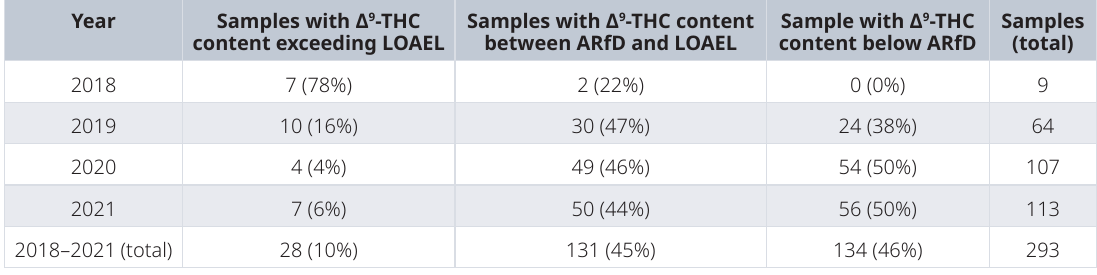
Table 2. Results 1 of THC analysis in commercial hemp-based products from the German market (2018–2021). Year Samples with Δ 9 -THC Samples with Δ 9 -THC content Sample with Δ 9 -THC Samples content exceeding LOAEL between ARfD and LOAEL content below ARfD